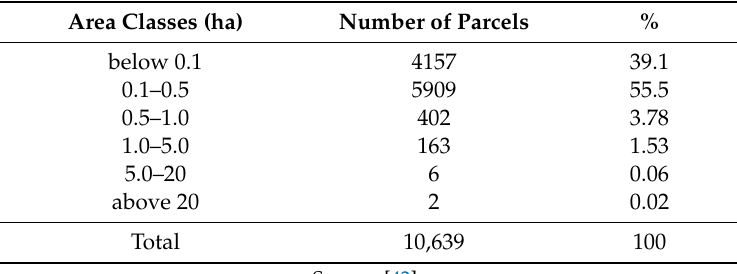
Figure 2. Monthly average climatic data for Leiria region (adapted from [45]); Precipitation ( ) and Maximum ( ), Average ( ) and Minimum Temperature ( ). Table 1. Number of parcels per area classes in the Table 1. Number of parcels per area classes in the LVID.